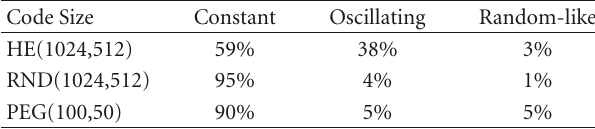
Table 1: Percentages of error patterns at error-floor